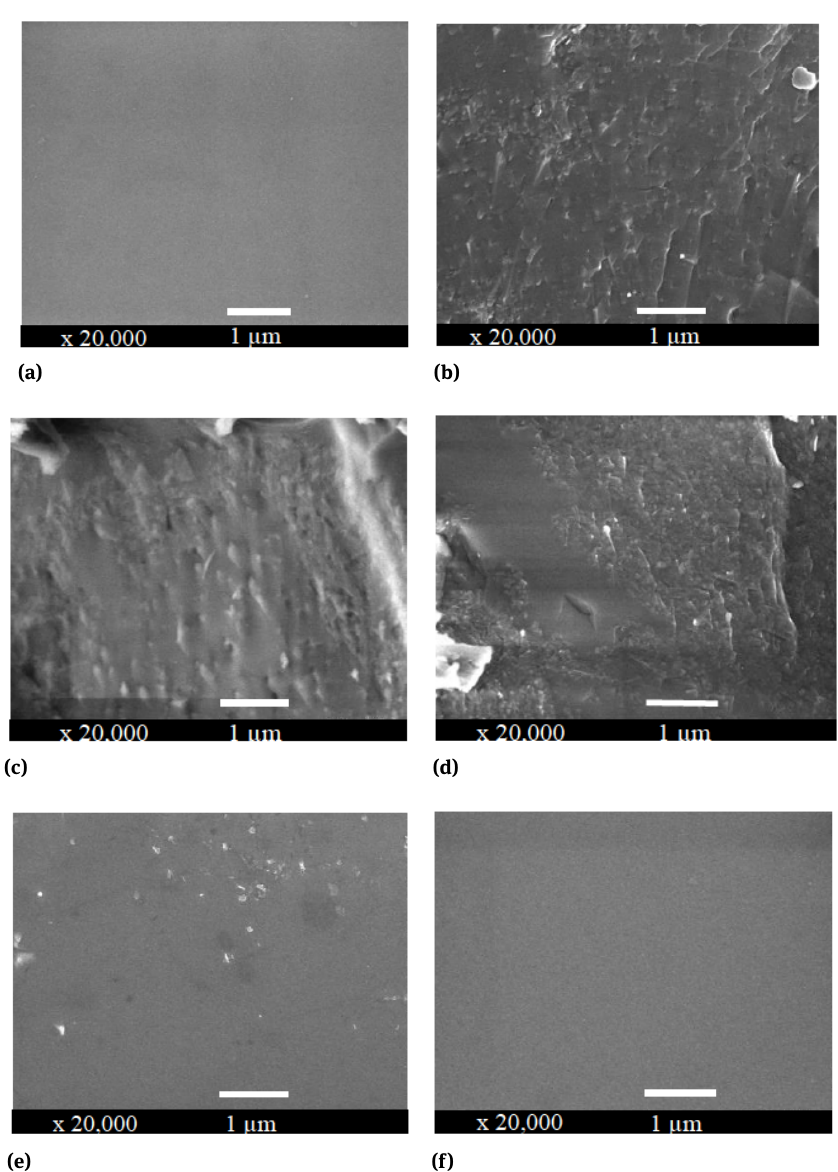
Figure 7: SEM micrographs of ceramic hand molds at surface and cross-sectional area with a magnification of 20,000X: a) and a-1) commer- cial hand molds; b) and b-1) porcelain hand molds fired at 1270 ∘ C, c) and c-1) bone china hand molds fired at 1270 ∘